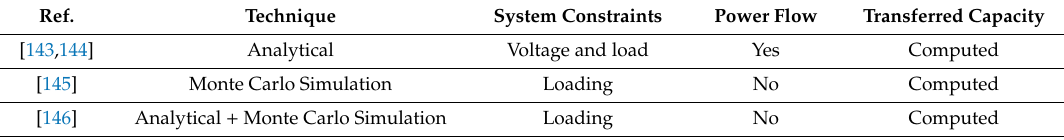
Table 5. Reliability assessment techniques for DGs in grid-connected mode of operation [126].